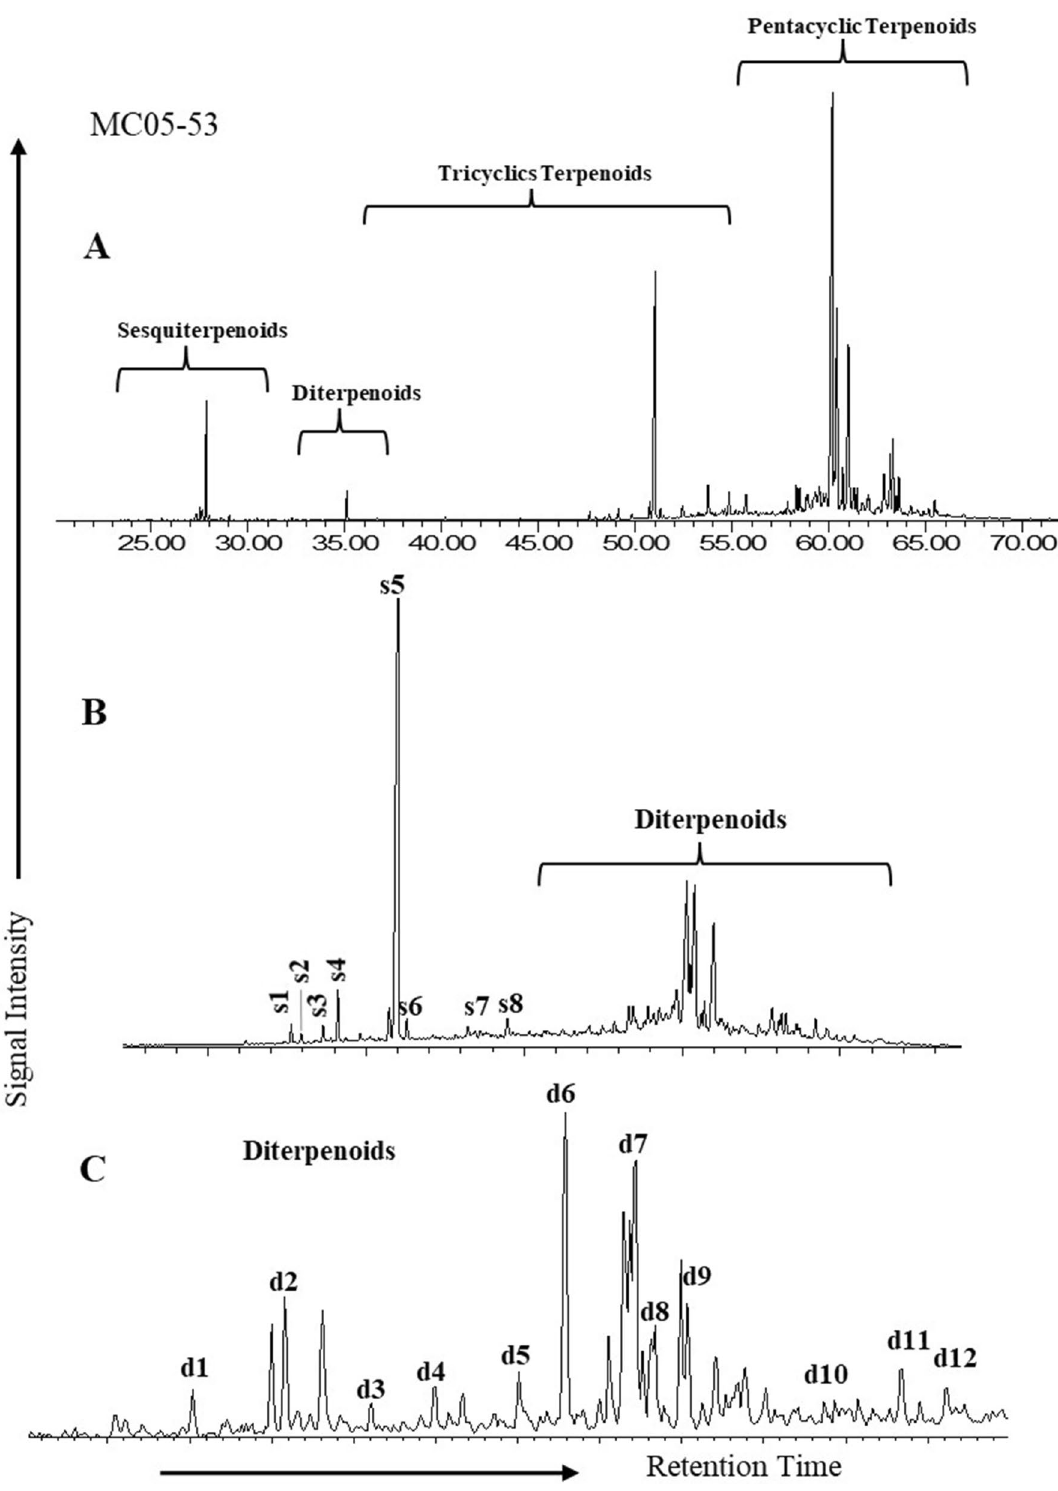
Figure 8. Examples of ( A ) total ion chromatogram (TIC), ( B ) sesquiterpanes ( m/z 123), and ( C ) diterpanes ( m/z 123) distributions of the analysed samples from the Mukah